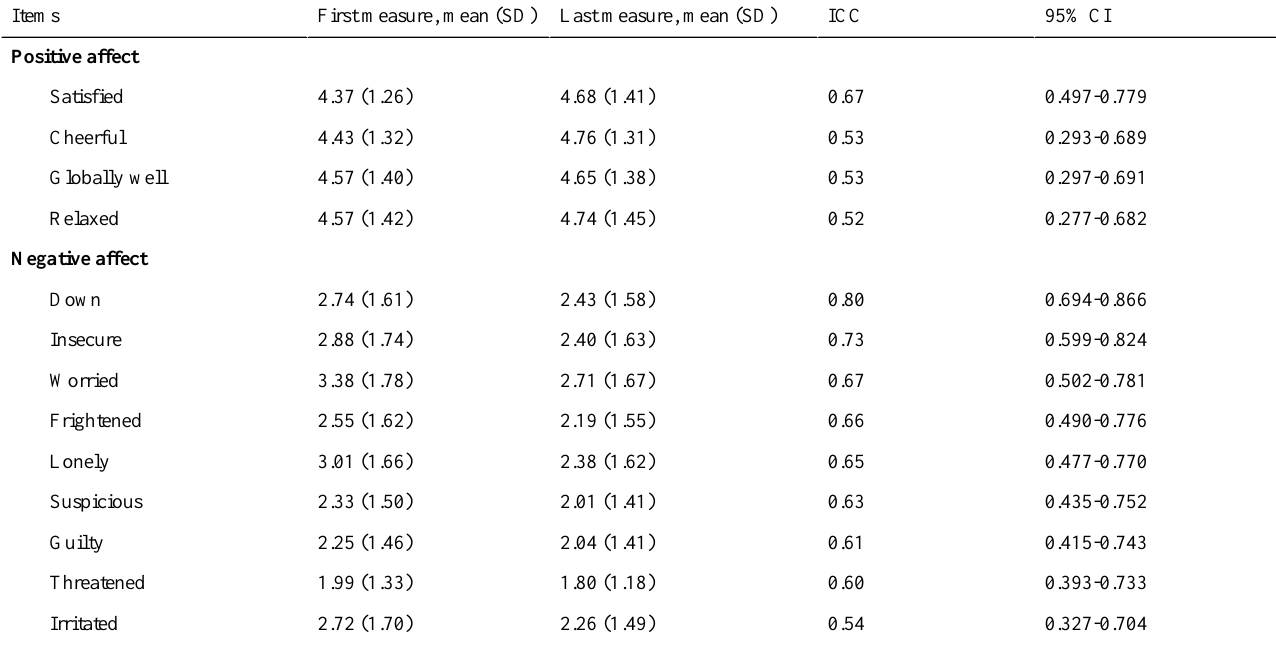
Table 4. ICC a and 95% CI of the K-PsyMate scale (n=93).